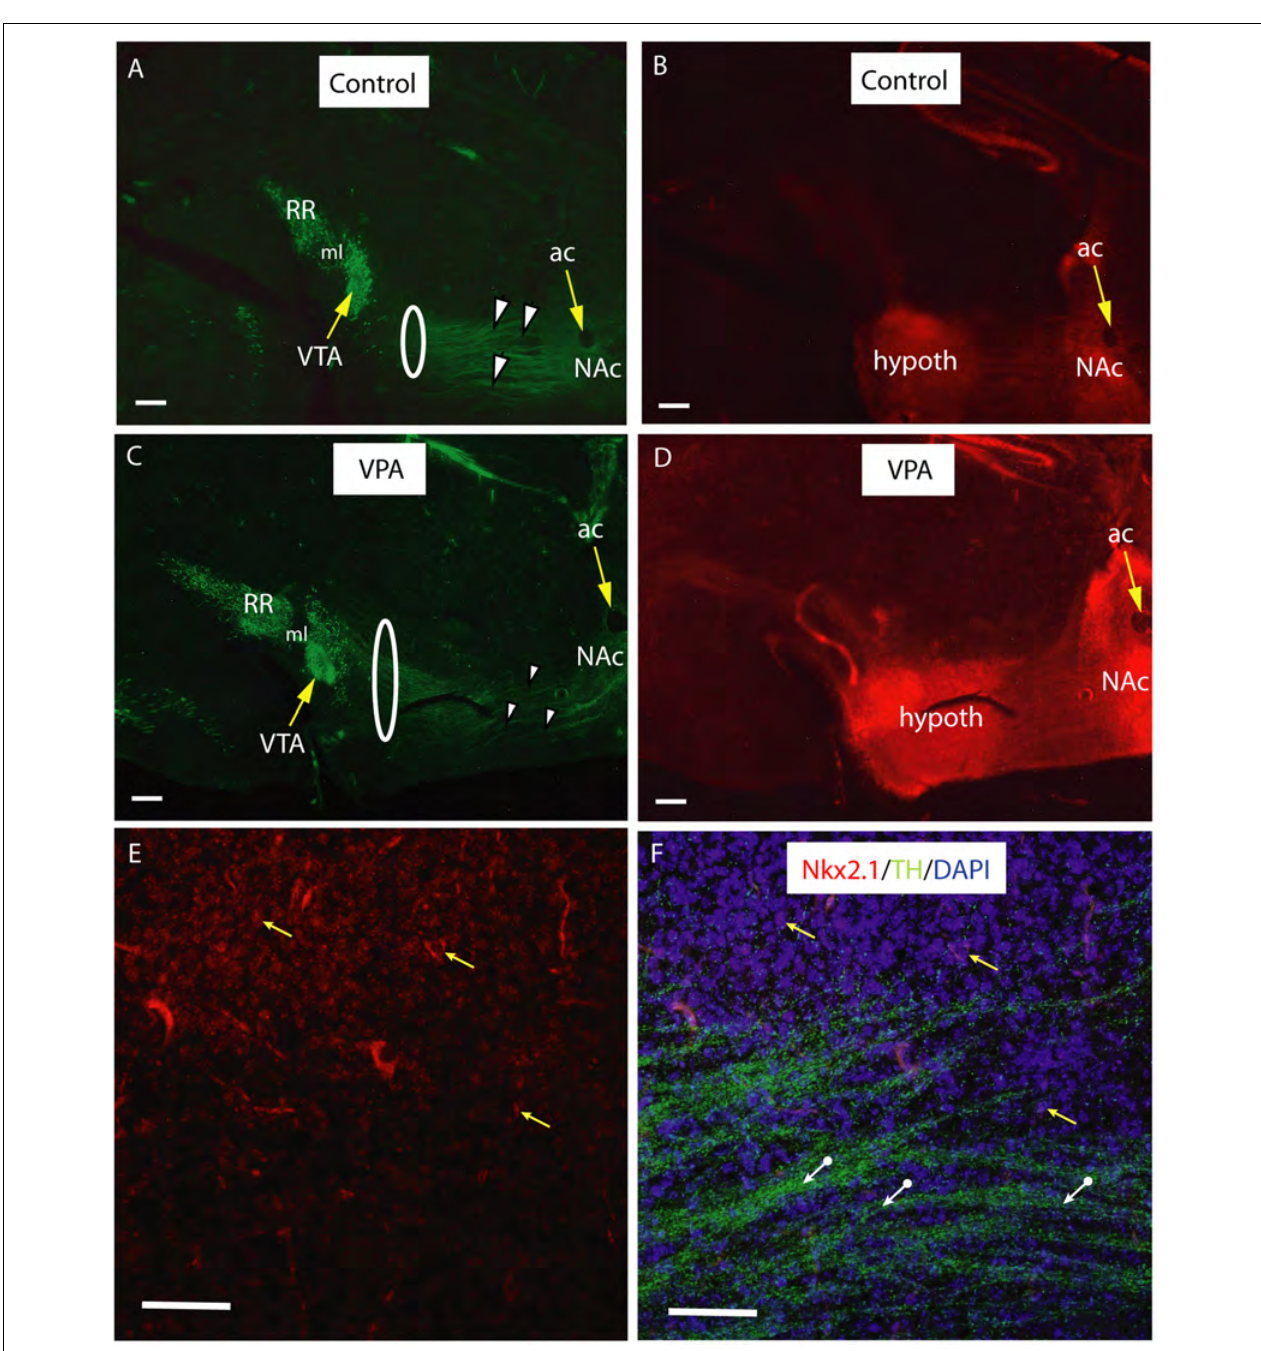
FIGURE 9 | Course and distribution of the mesotelencephalic dopaminergic pathway in control and VPA exposed E18.5 mice from a tdTomato reporter line crossed with hemizygous mice expressing Cre recombinase driven by TTF-1 (Nkx2.1) promoter. Sagittal sections immunolabeled against TH (green fluorescence). Intrinsic red fluorescence of the tdTomato reporter marks the expression of Nkx2.1. For better definition, the two channels are shown as separate images. (A–D) Matching pairs of images from control (A,B) and VPA-exposed (C,D) mouse embryos. Note the clear separation between the VTA (A10) and the retrorubral field (A8, RR) in the source region of mesotelencephalic fibers (A,C) . Fasciculation of TH+ fibers traversing the Nkx2.1 + hypothalamic zone (arrowheads) is more prominent in the control specimen, as compared to the VPA-exposed specimen, whereas the same pathway appears to be wider in VPA treated samples (highlighted by the loops in A,C ). Hypothalamic and ventrobasal forebrain localization of Nkx2.1 expression looks similar in Control and VPA specimens (B,D) . (E,F) Confocal laser scanning microscope images from a representative control section demonstrating the presence of Nkx2.1 expressing nuclei in the hypothalamic region ( E ; Channel 1 for tdTomato signal). A few examples of matching DAPI labeled nuclei (yellow arrows), and the TH+ fibers (white arrows) traversing the Nkx2.1 positive matrix are visible in ( F ; Channel 2 for the combined blue and green signals). Scale bars: 50 µ m. Abbreviations: ac, anterior commissure, hypoth, hypothalamus, ml, medial lemniscus, NAc, nucleus accumbens, VTA, ventral tegmental